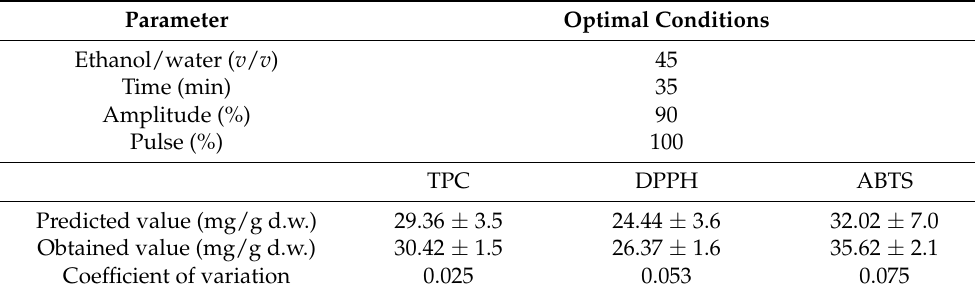
Table 3. Optimal conditions selected and the model predicted values with the obtained values expressed with the mean and the standard deviation.